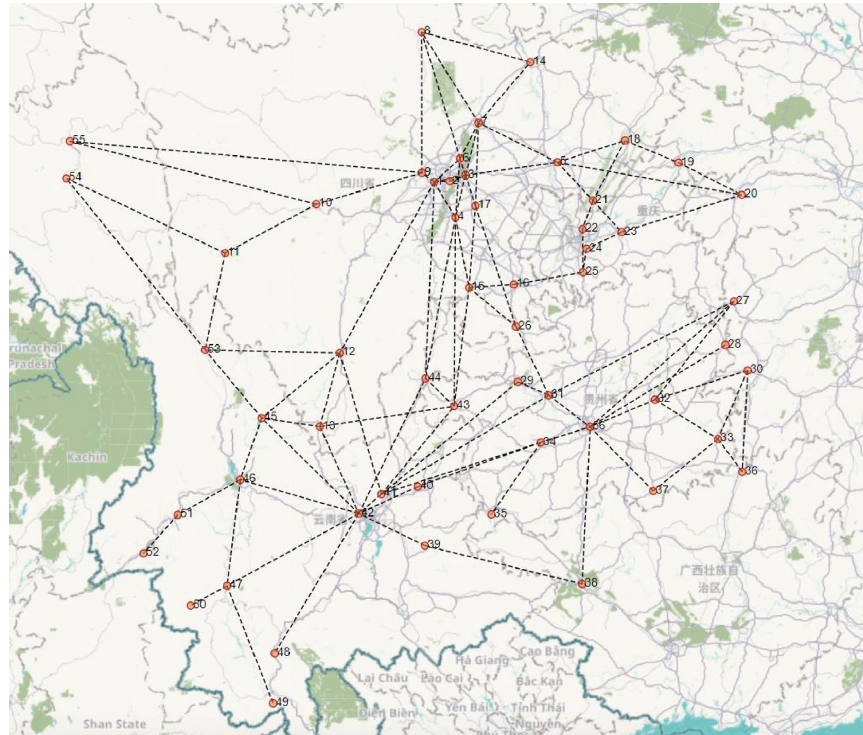
Figure 1: Navigation network in Southwest China. There are 5 provinces in Southwest China, including 56 navigation stations. Table 2: Main statistic characteristics of the navigation network.